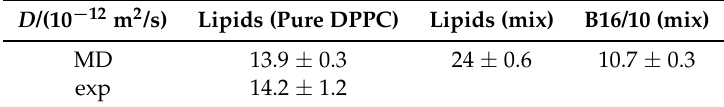
Table 1. Lateral self-diffusion coefficients ( D ) at 335 K obtained from MD simulation (MD) and experimental data from literature (exp) [42]. Uncertainties are given as three times the standard